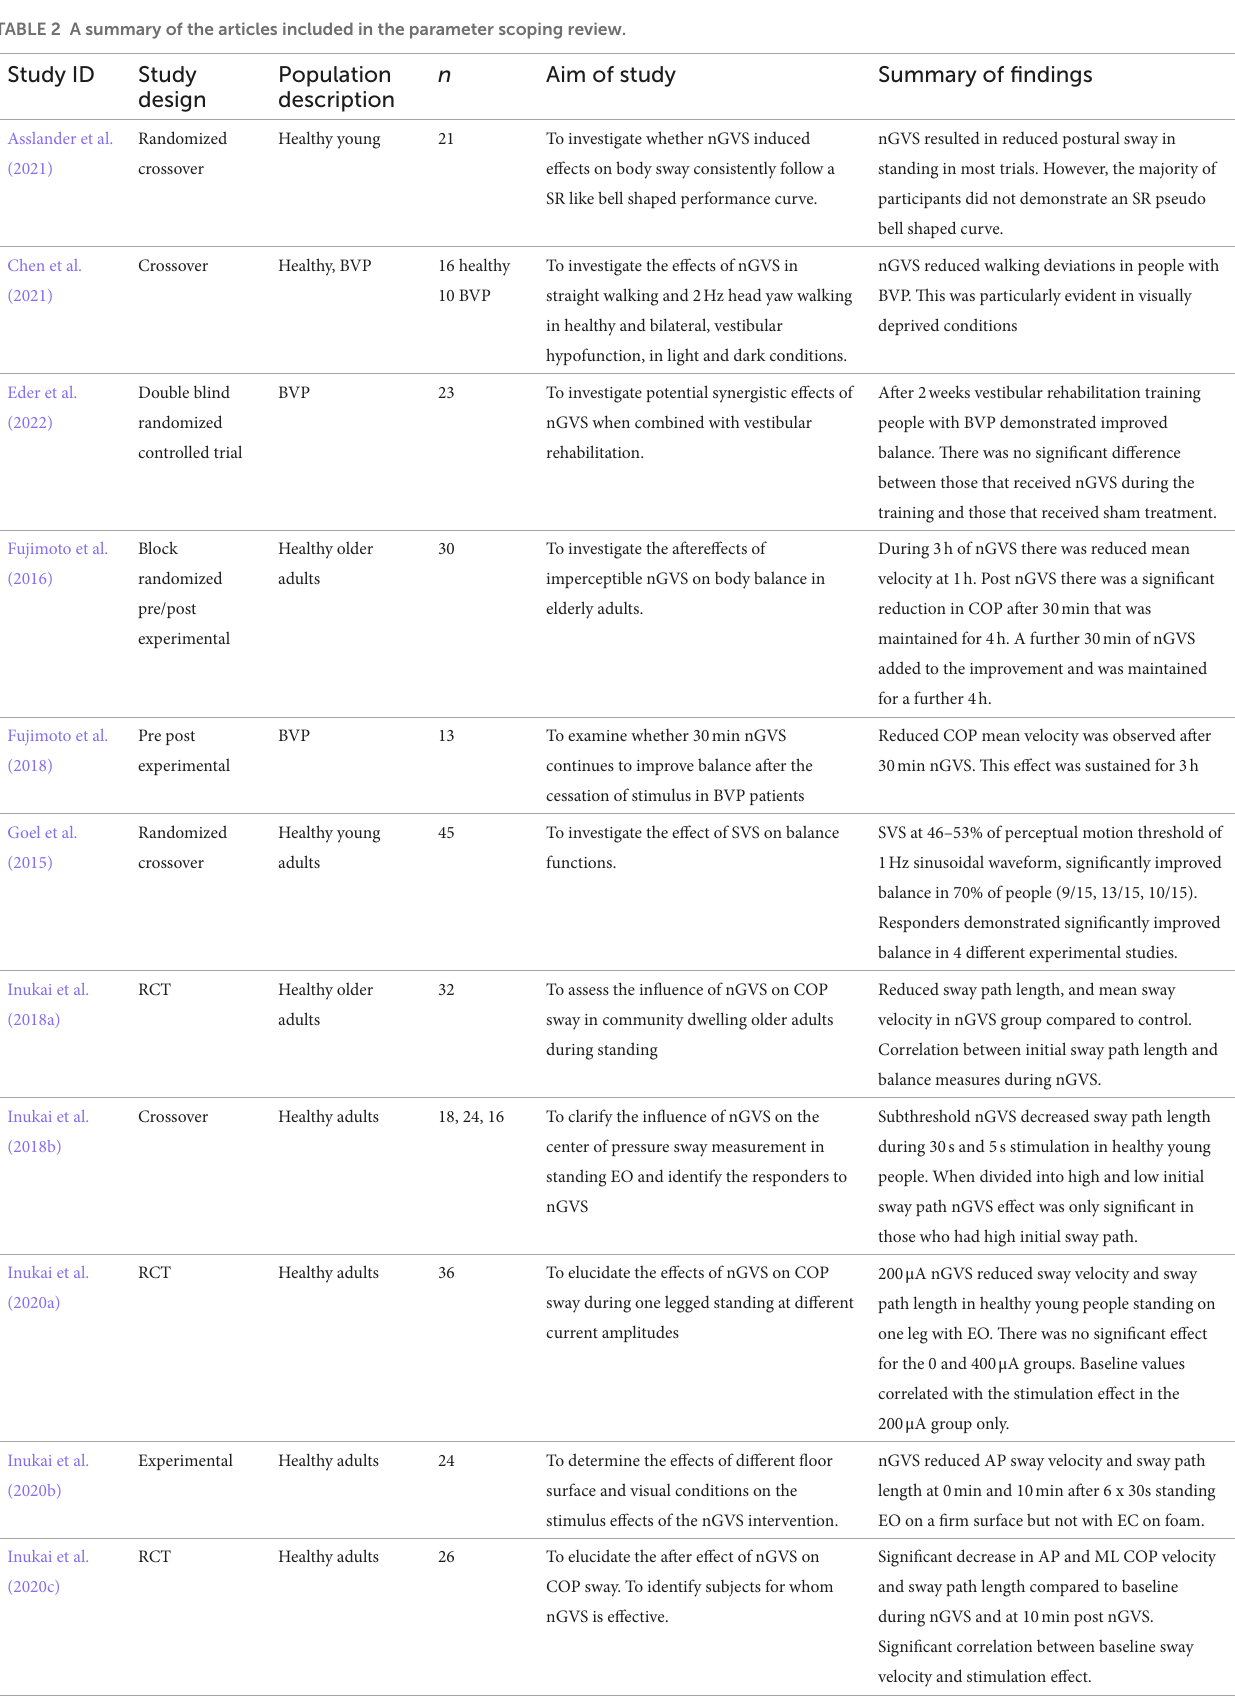
TABLE 2 A summary of the articles included in the parameter scoping